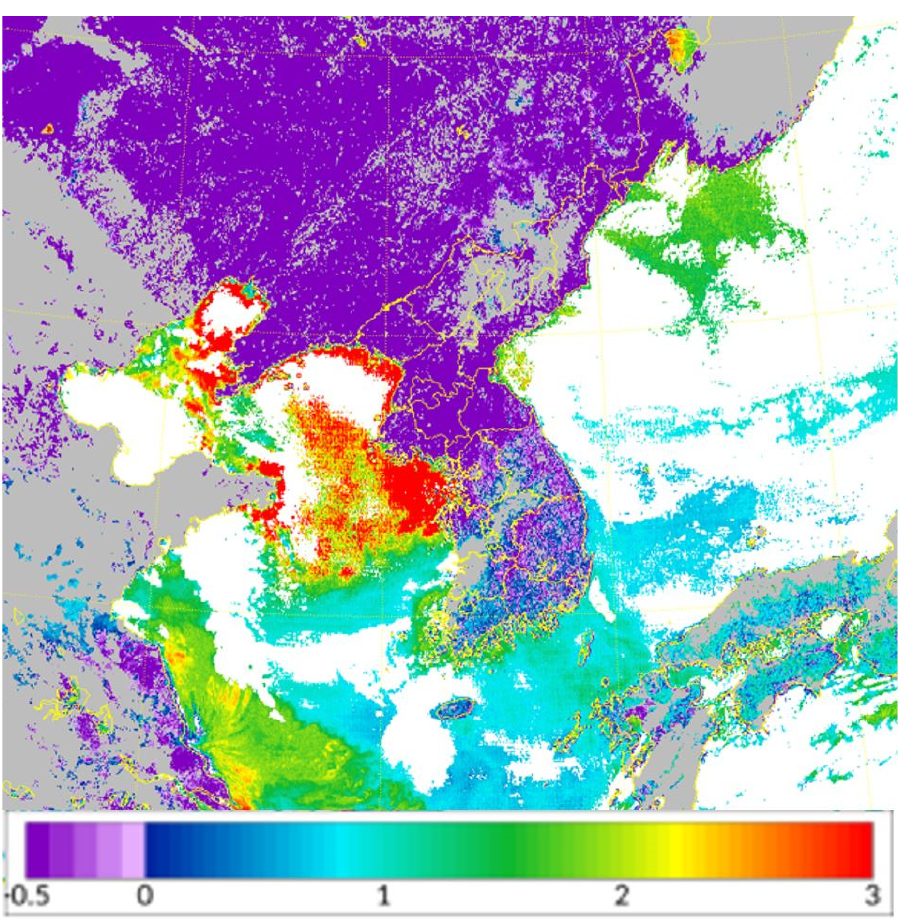
Figure 1 shows an example of a satellite image with aerosol particle size color legend on the bottom right corner. Aerosol particle size is expressed as α . Particle size is exponential using the ratio of the two wavelengths to the corresponding optical thickness, and the range of α is − 0.5–3 [10]. In Figure 1, it can be seen that the colors are different depending on the calculation range of α , and the purple series ( α : − 0.5–0) and the blue series ( α : 0–1) represent large aerosols such as yellow dust and sea salt particles. The green series ( α : 1–2) denote medium-sized aerosols, and the yellow and red ( α : 2–3) correspond to fine aerosols, such as pollutants or smoke. That is, the smaller the production range of α , the larger the size of the aerosol particle, and the greater the production range of α , the smaller the size of the aerosol particle.